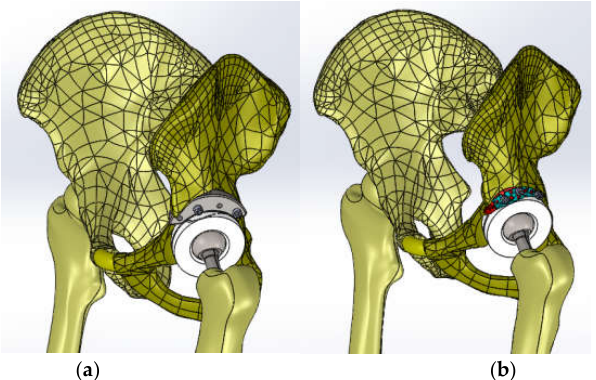
Figure 32. Final geometry of the hip joint with revision prosthesis in SolidWorks. ( a ) Orthopaedic prosthesis with titanium augment. ( b ) Orthopaedic prosthesis with morcellated graft and reconstructive mesh.